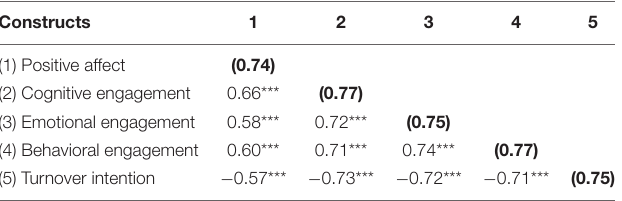
TABLE 3 | Construct discriminative validity analysis ( n =